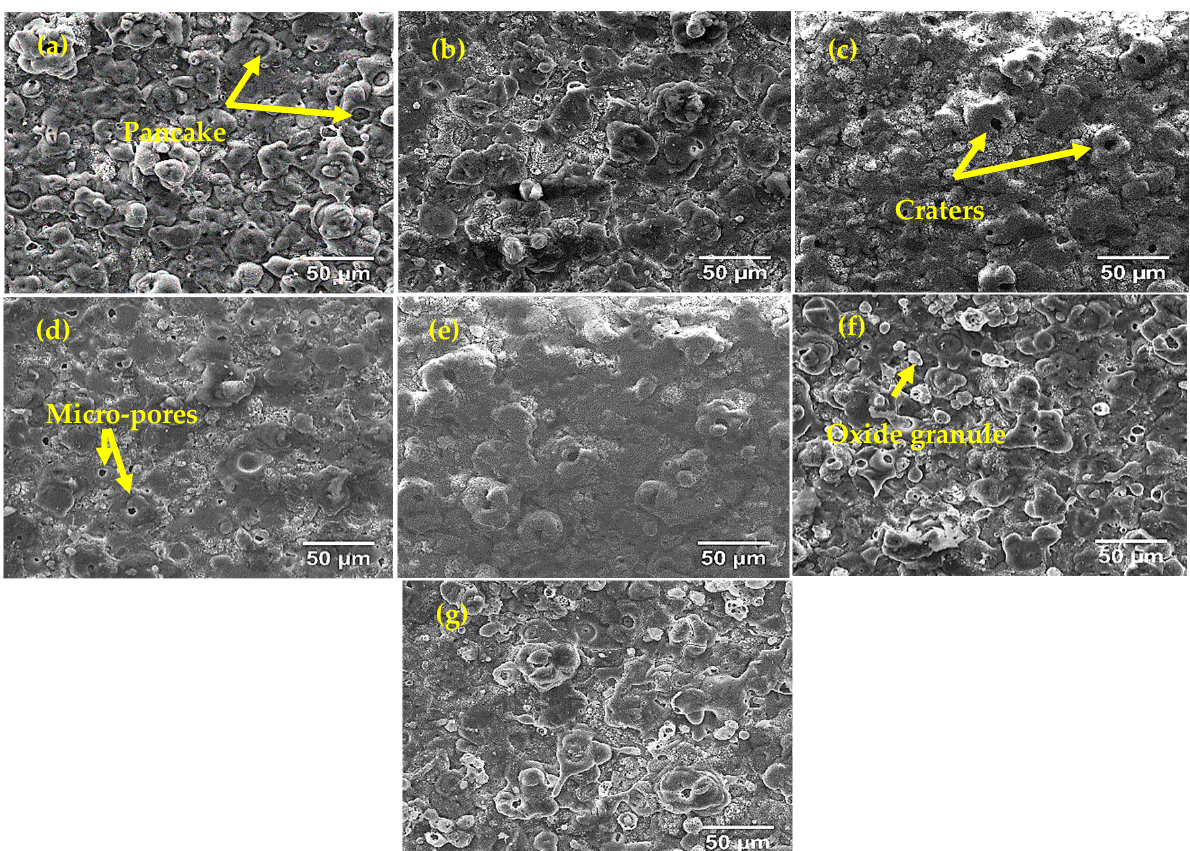
Figure 5. Surface morphology of the produced coatings: ( a ) S1W, ( b ) S3W, ( c ) S5W, ( d ) S7W, ( e ) S9W, ( f ) S11W, and ( g ) S13W.